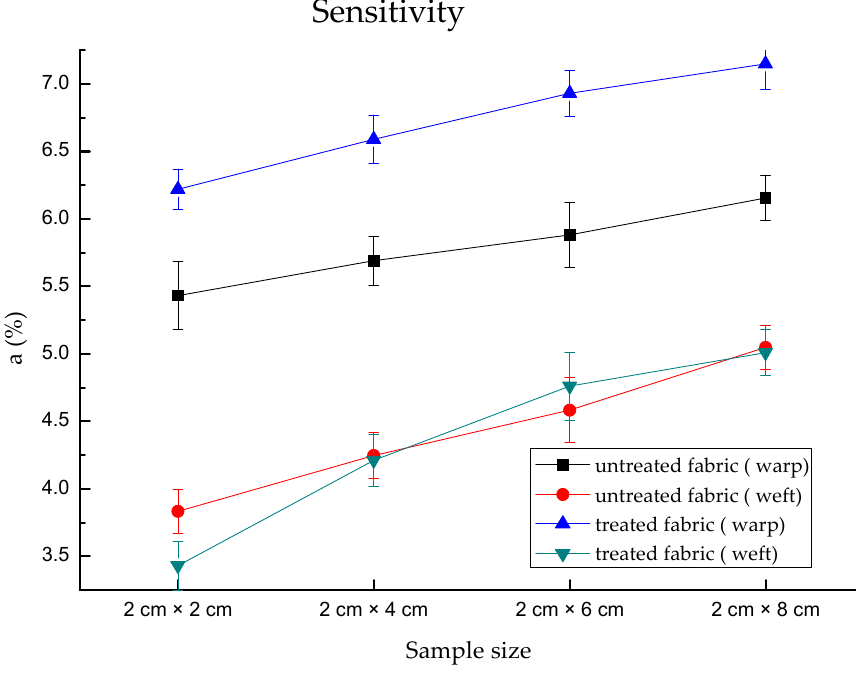
Figure 10. The sensitivity of untreated and treated fabrics. Treated fabric in the warp direction had higher sensitivity.